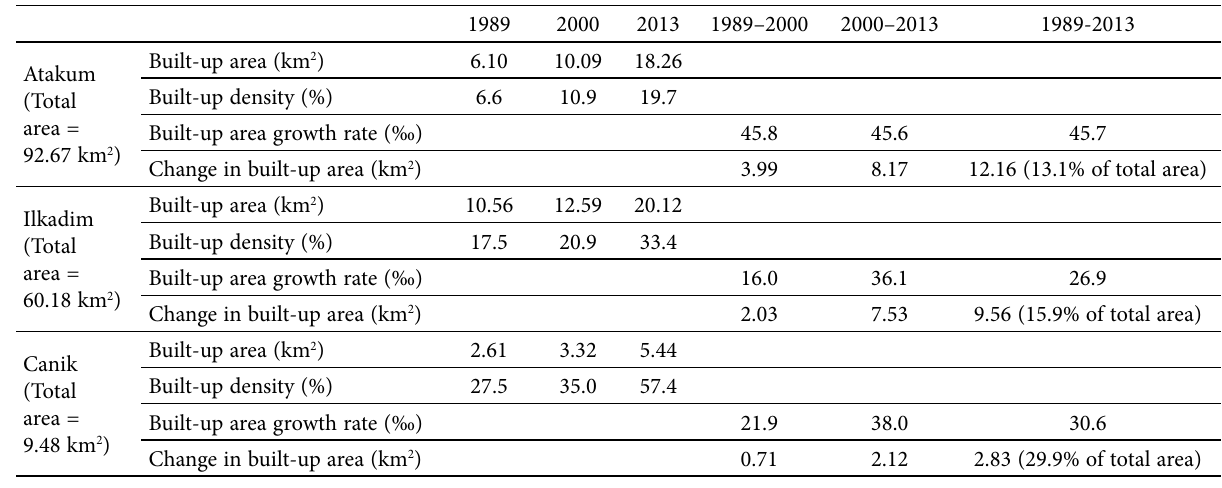
Table 1. The changes in the built-up area and built-up area density over time in Atakum, Ilkadim and Canik